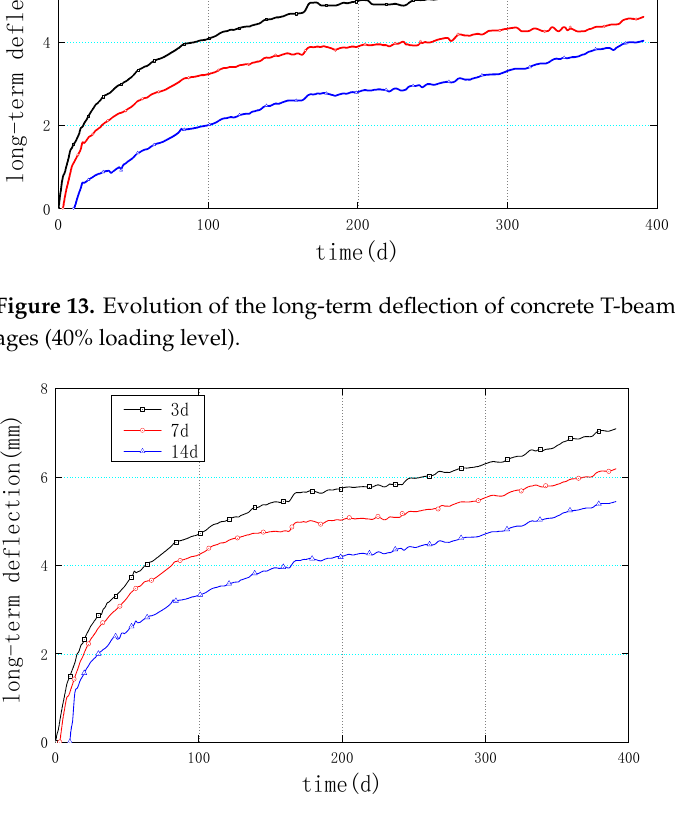
Figure 14. Evolution of the long-term deflection of concrete T-beam specimens at various loading ages (70% loading level).